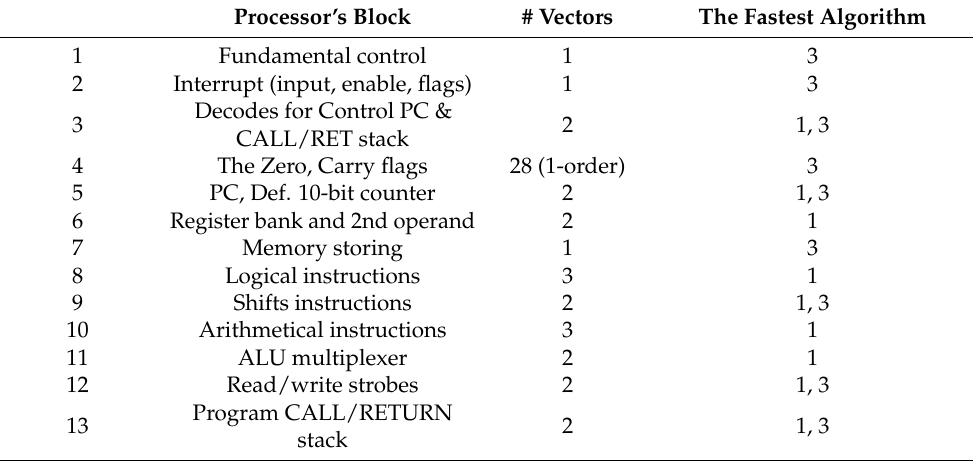
Table 5. Number of local test